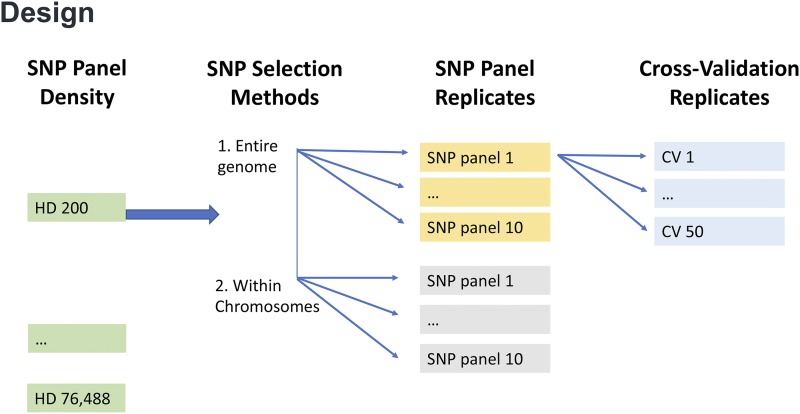
Experimental design.